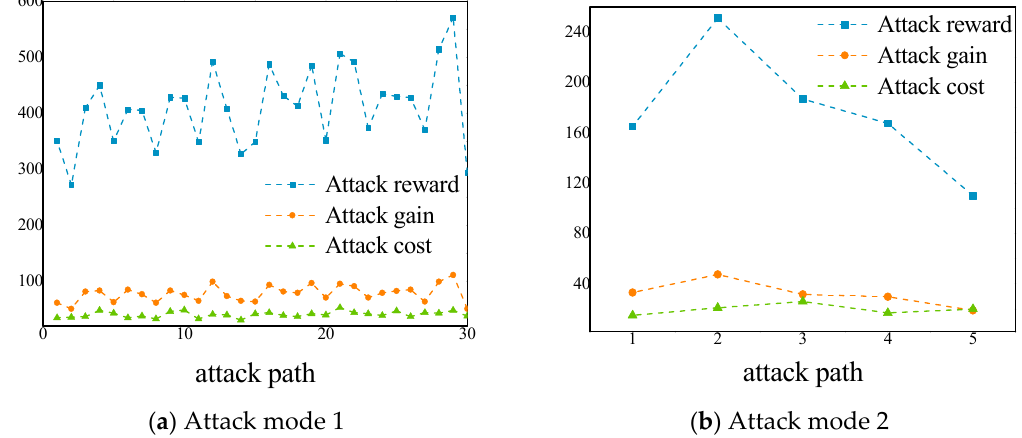
Figure 4. The relationship between attack gain, attack reward, and attack cost: ( a ) attack mode 1, ( b ) attack mode 2.